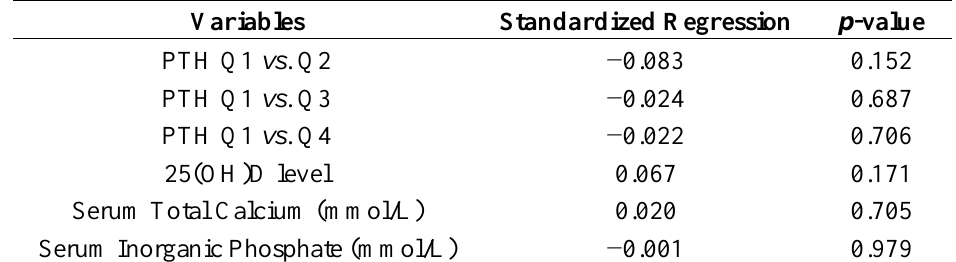
Table 6. The association between calcaneal speed of sound and biochemical variables related to calcium homeostasis. PTH,